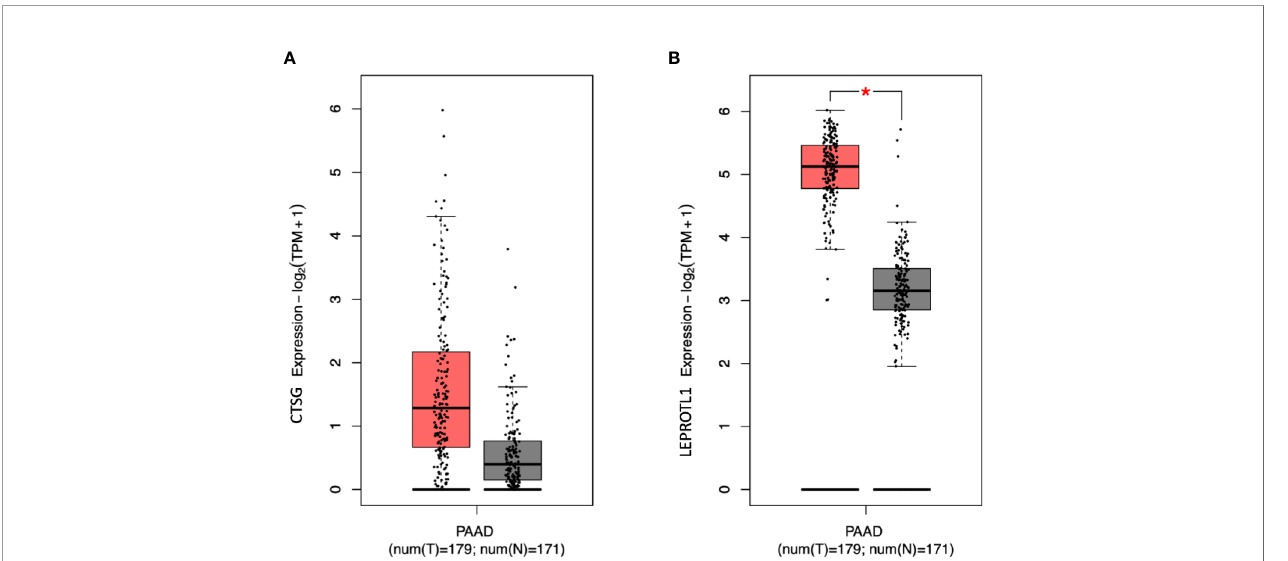
FIGURE 2 | The expression level of CTSG and LEPROTL1 in PAAD patients. GEPIA2 generates box plot for comparing gene expression in pancreatic cancer and paired normal tissues (TCGA tumor versus TCGA normal + GTEx normal). (A, B) differential expression analysis. Peach and grey clusters represent tumor and normal samples; * genes with higher |log2FC| values (>1) and lower Q-values (<0.01) were considered differentially expressed